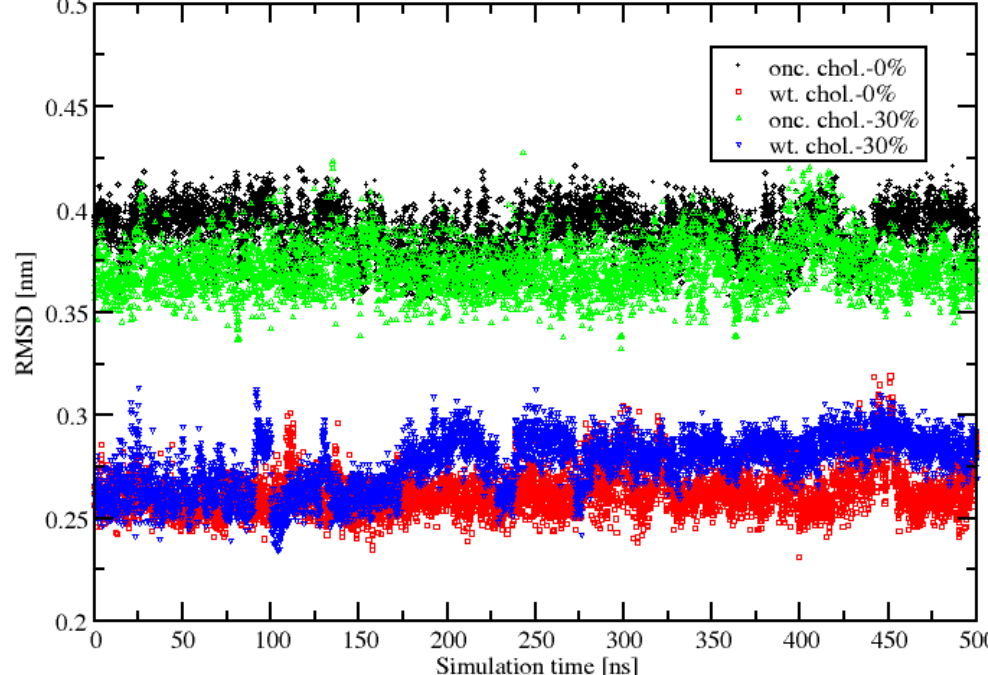
Figure 3. The RMSD of the 5-aa-sequence of the HVR during the last 500 ns of the 1 µ s time span for four